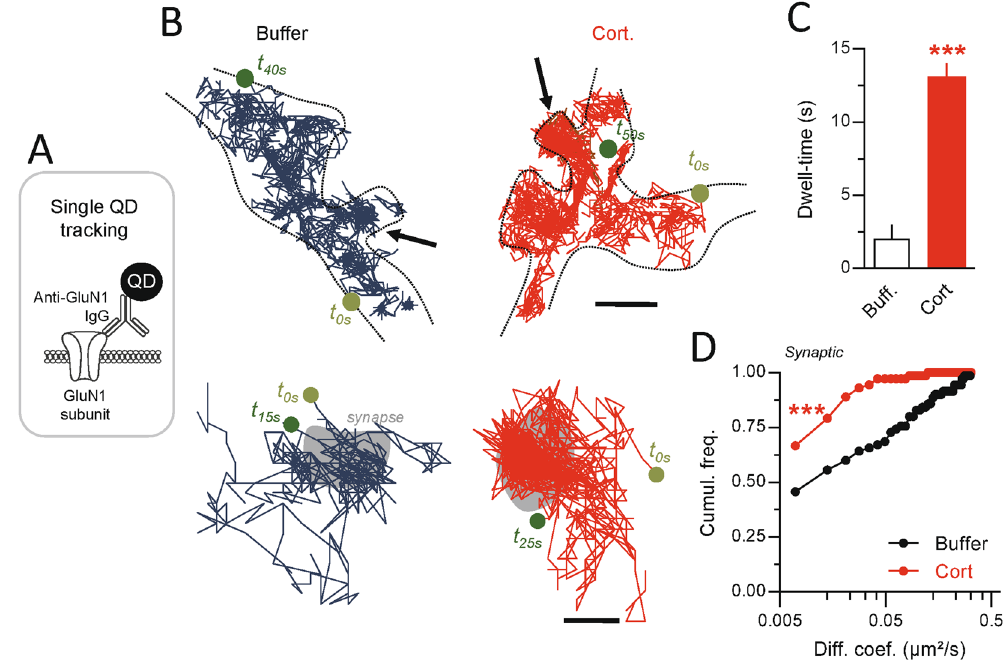
Figure 3. Corticosterone decreases the surface dynamics of GluN1-NMDAR in hippocampal neurons exposed to corticosterone. ( A ) Schematic representation of antibody against GluN1 subunit and single QD complex used to label and track surface NMDAR. ( B ) Representative trajectories of single GluN1-NMDAR in control (buffer, blue) and corticosterone (100 nM, 20 min; red). Note that the traces represent different receptors. The black arrows point toward spines in which glutamatergic synapses were identified. Lower panels, enlarged trajectories located within the postsynaptic densities (gray areas). Starting and ending time of the single trajectories are indicated as for instance time 0 (t 0s ). ( C ) Comparison of the synaptic dwell-time (expressed in seconds) of surface GluN1-NMDAR in buffer (n = 55 trajectories) or corticosterone (n = 62 trajectories) condition. *** p < 0.001, Student t-test. ( D ) Comparison of the cumulative distributions of GluN1-NMDAR instantaneous diffusion coefficients in buffer (n = 172 trajectories) and corticosterone (n = 190 trajectories) conditions. *** p < 0.001, Kolmogorov-Smirnov